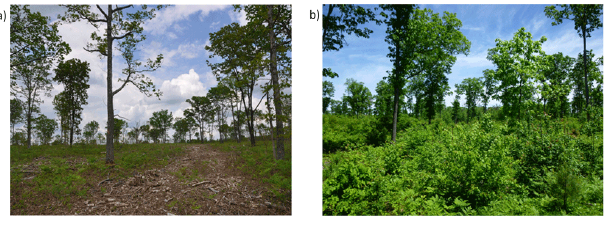
Fig. 3 . Example of regenerating stands in Pennsylvania with (a) interspersed residual trees postharvest and (b) a mix of snags, saplings, shrubs, forbs, grasses, and bare ground 3 years postharvest.